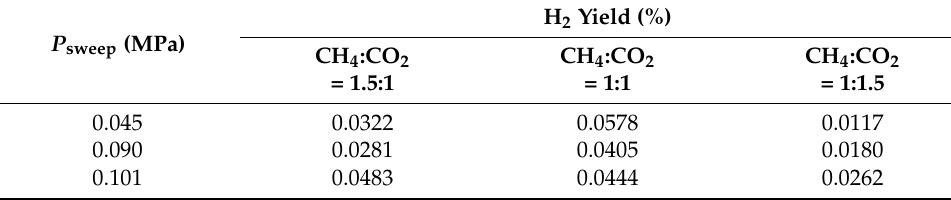
Table 8. Relationship between H 2 yield and p sweep changing molar ratios of CH 4 :CO 2